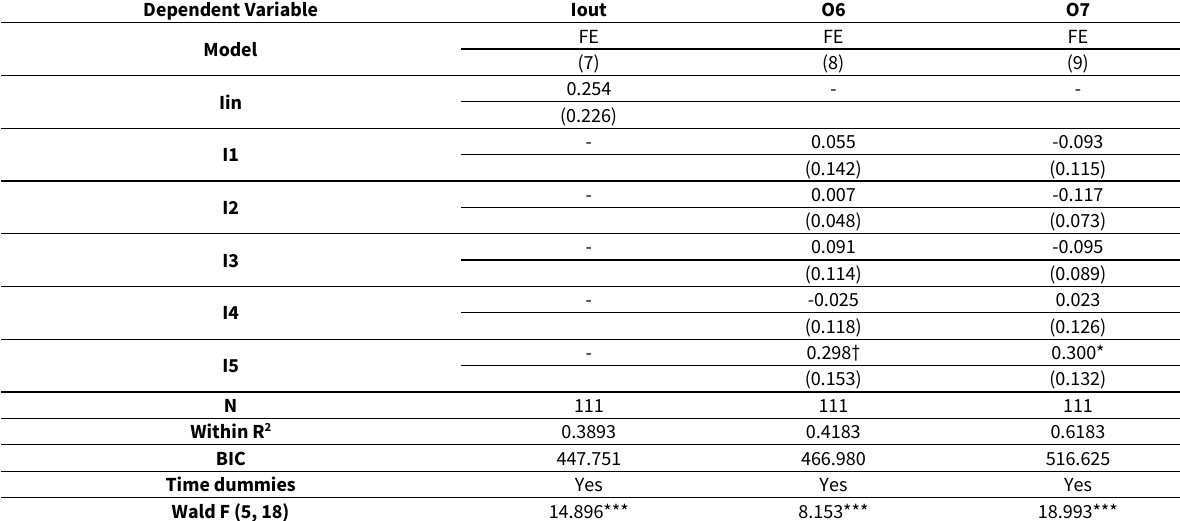
Table 9. Results of Fixed Effects regressions (Eurozone